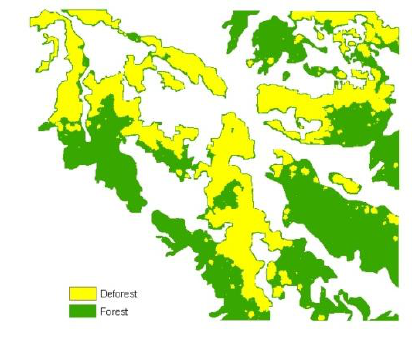
Figure 4: simulated deforestation in